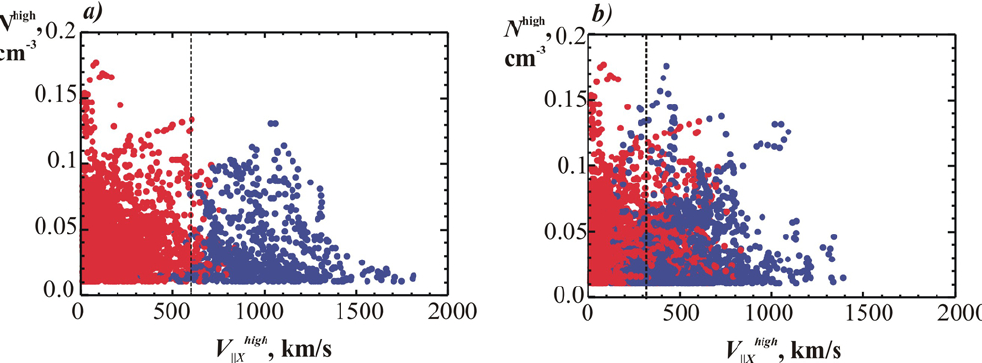
Fig. 10. (a) A scatterplot of the ion density N high versus the X-component of the parallel velocity V high || of the spectrum in the lobe side of the PSBL (blue dots) and in the outer PS (red dots); (b) a scatterplot of the same moments, measured in the inner part of the PSBL, where counterstreaming ion beams are observed (blue dots) and in the outer PS (red dots). Samples with very low densities ( < 0.01cm − 3 ) are